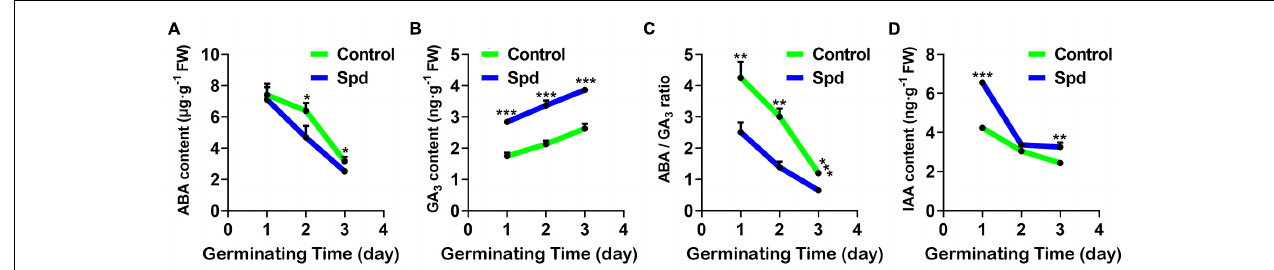
FIGURE 3 | The contents of endogenous hormones. (A) Content of ABA. (B) Content of GA 3 . (C) The ratio of ABA/GA 3 . (D) Content of IAA. Vertical bars indicate mean ± SD ( n = 3), and * or ** or *** indicates a significant difference at the level of p < 0.05 or at the level of p < 0.01 or at the level of p < 0.001, respectively. IAA, indole acetic acid; ABA, abscisic